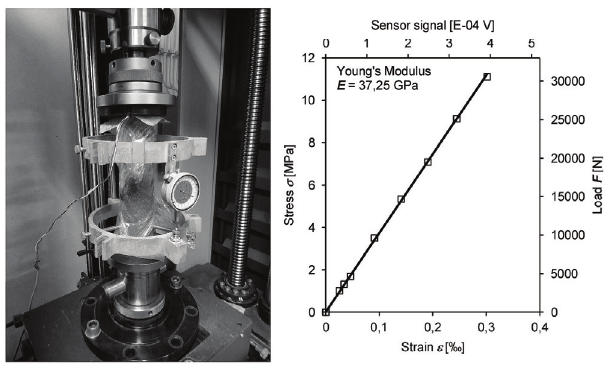
Fig. 2. Deformability tests for cylindrical samples and Young’s modulus